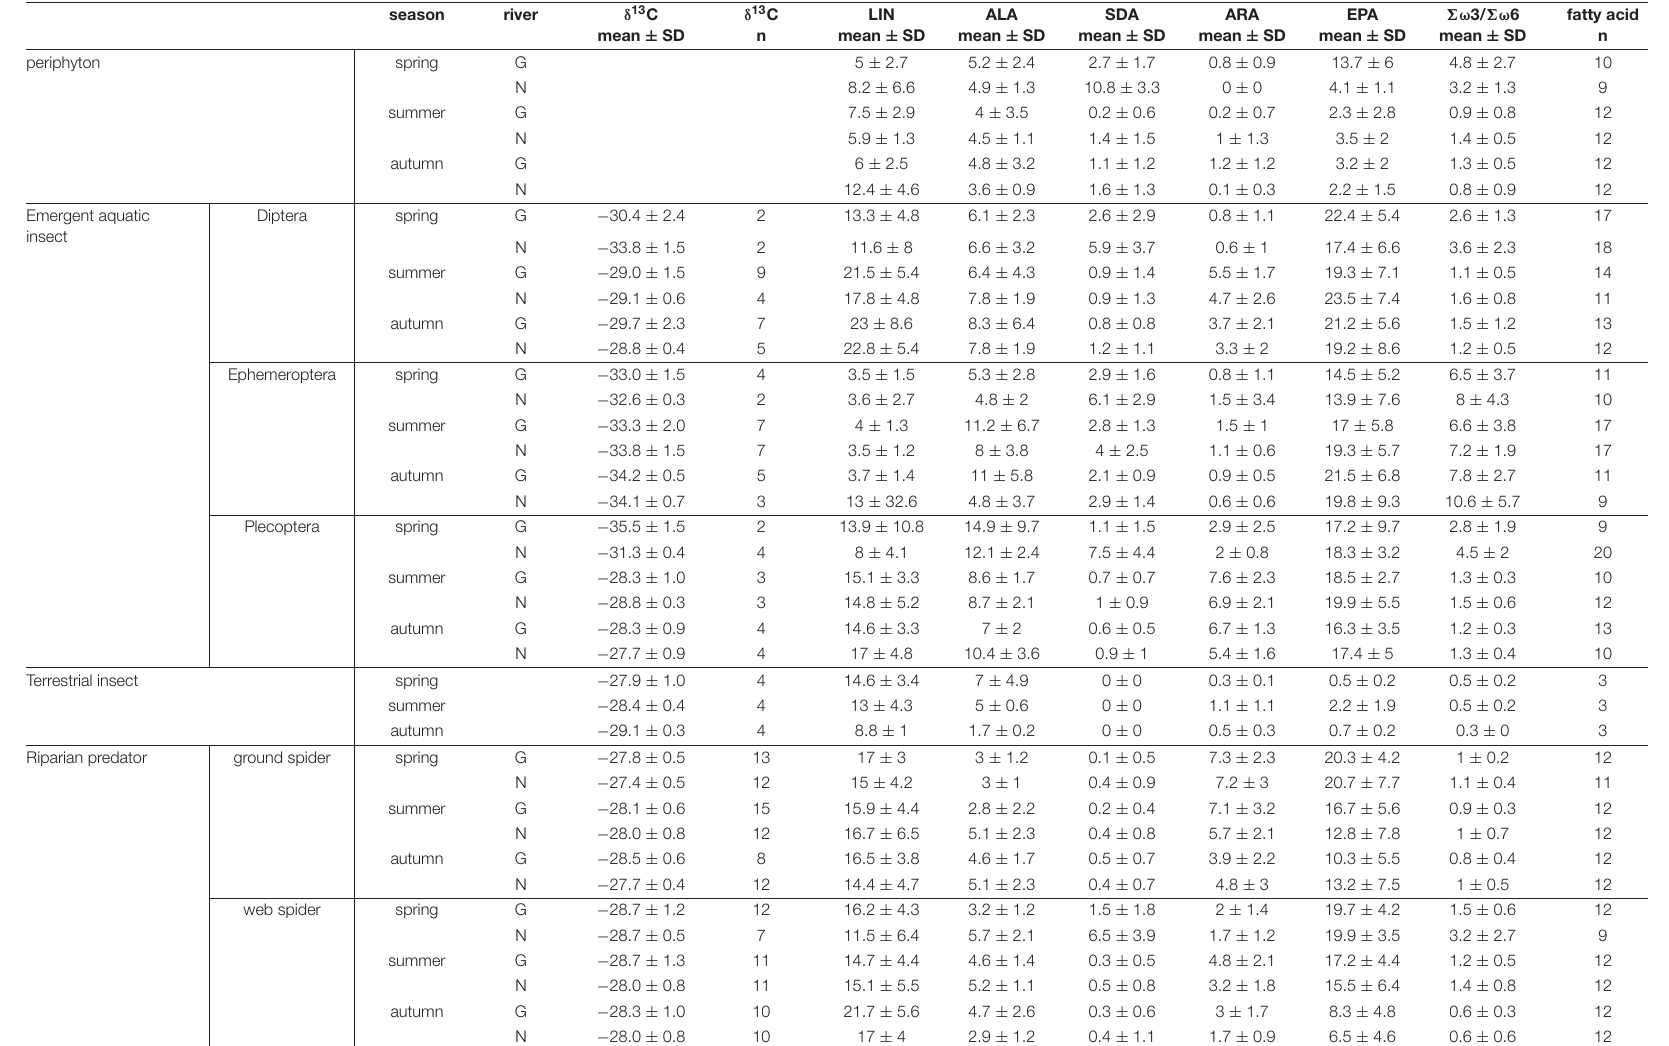
TABLE 1 | Carbon isotope ratios and individual PUFAs (% of total fatty acids) for the different trophic levels by stream and season (mean ± standard deviation). N, Necker; G,